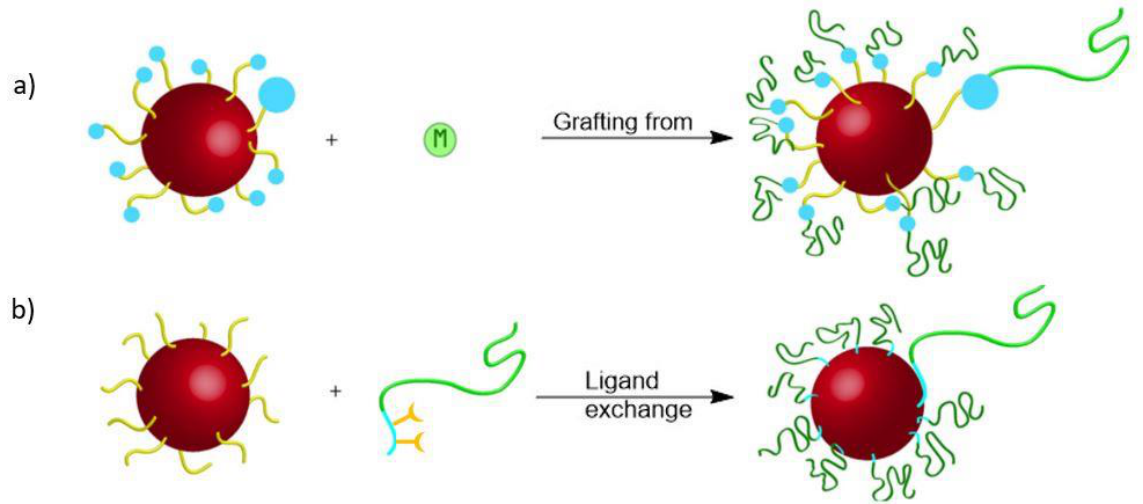
Figure 2. The coating of nanoparticles can either be done by a grafting from ( a ) or a grafting to ( b ) process. In the last case the ligand exchange is shown; reproduced with permission from [24]; published by Wiley-VCH, 2015.